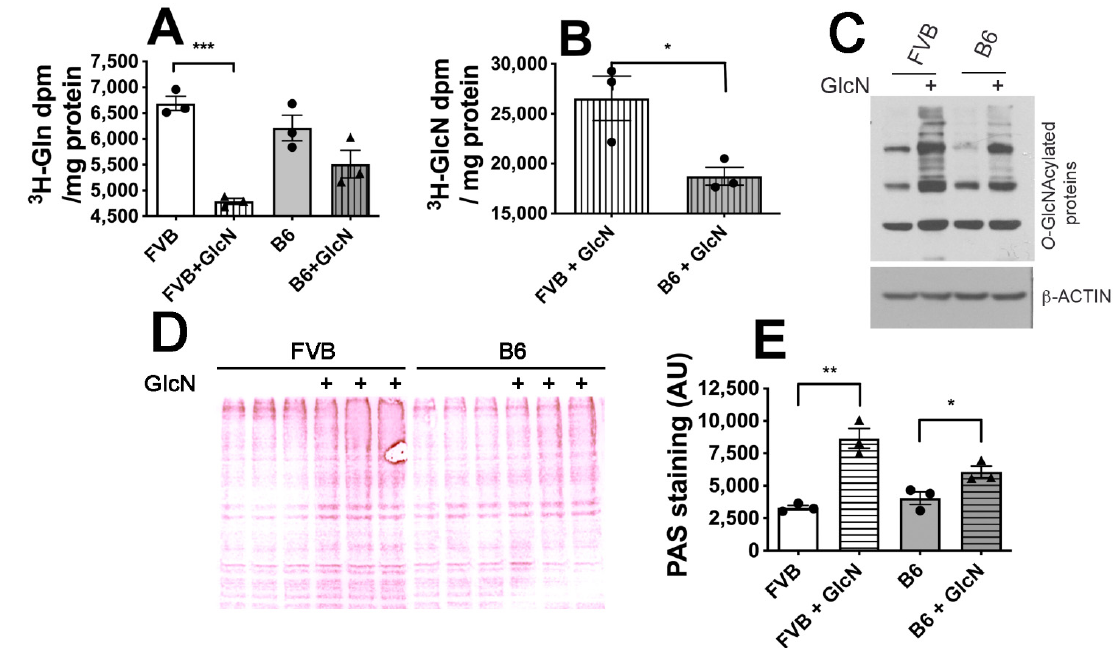
Figure 3. Glycosylation substrate utilization by FVB and B6 LG-ESC. ( A ) WGA-precipitated glycoproteins labeled with 3 H-glutamine from FVB and B6 LG-ESC cultured ± 0.8 mmol/L GlcN. ( B ) WGA-precipitated glycoproteins labeled with 3 H-GlcN from FVB and B6 LG-ESC. ( C ) Immunoblot of O -GlcNAcylated proteins following culture of FVB or B6 LG-ESC ± 0.8 mmol/L GlcN. ( D ) Periodic acid-Schiff (PAS) stain of N -glycosylated proteins separated by SDS-Polyacrylamide gel electrophoresis from three replicate culture dishes following culture of FVB or B6 LG-ESC ± 0.8 mmol/L GlcN. ( E ) Quantitation of PAS staining from ( D ). Data shown are means ± SEM and were analyzed by Student t test. * p < 0.05; ** p < 0.01; *** p < 0.001.